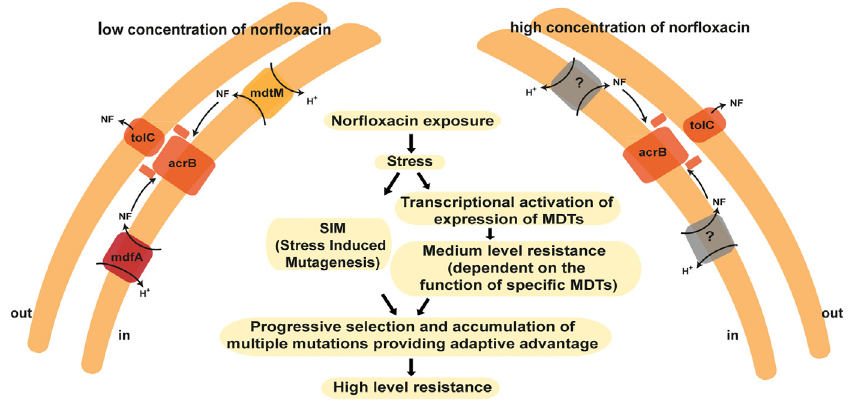
Fig 5. Sequence of events leading to high-level resistance. In this sequence, the role of the MDTs is to allow fixation of mutations that otherwise would be lost in the next increase in